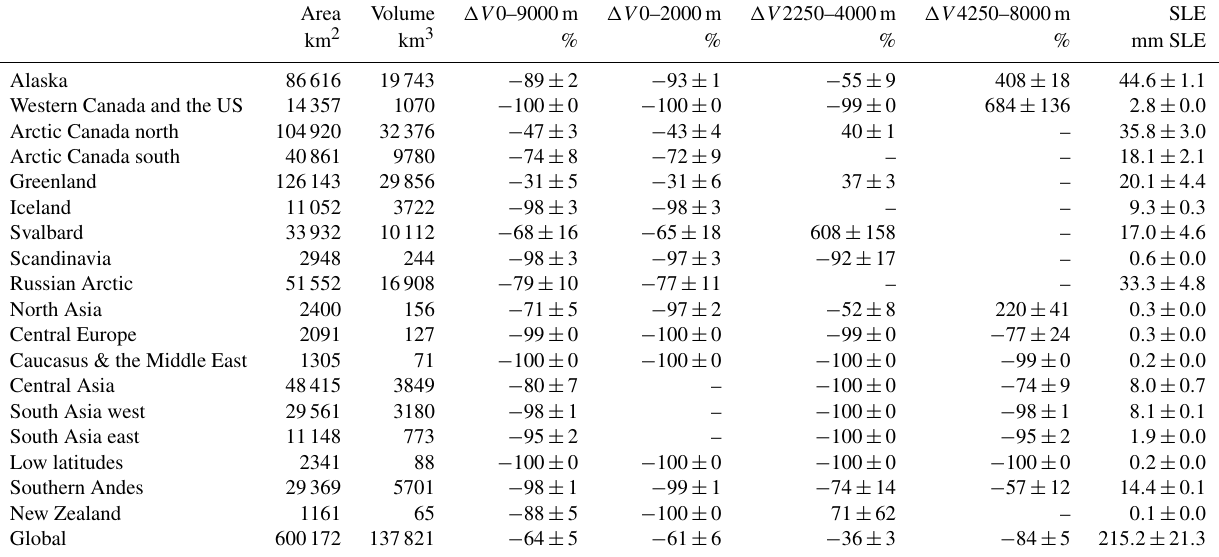
Table 6. Percentage ice volume loss, relative to the initial volume ( (cid:49)V ), and ice loss in millimetres of sea level equivalent (SLE) for the end of the century (2097). Percentage volume losses are shown for low, medium, and high elevation ranges as well as for all elevations. The data show the multi-model mean ± 1 standard deviation. The conversion of volume to SLE assumes an ocean area of 3 . 618 × 10 8 km 2 . The initial area and volume from the Randolph Glacier Inventory version 6 are listed in columns 1 and 2.